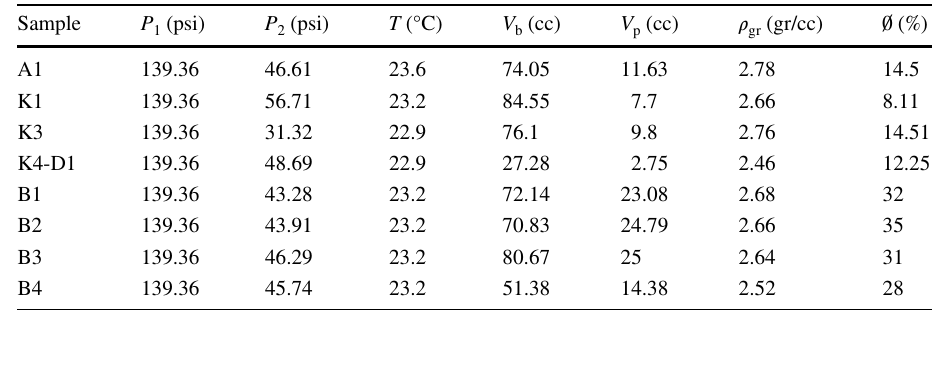
Fig. 7 The carbonate chip sam- ples (B1 and B2 samples)